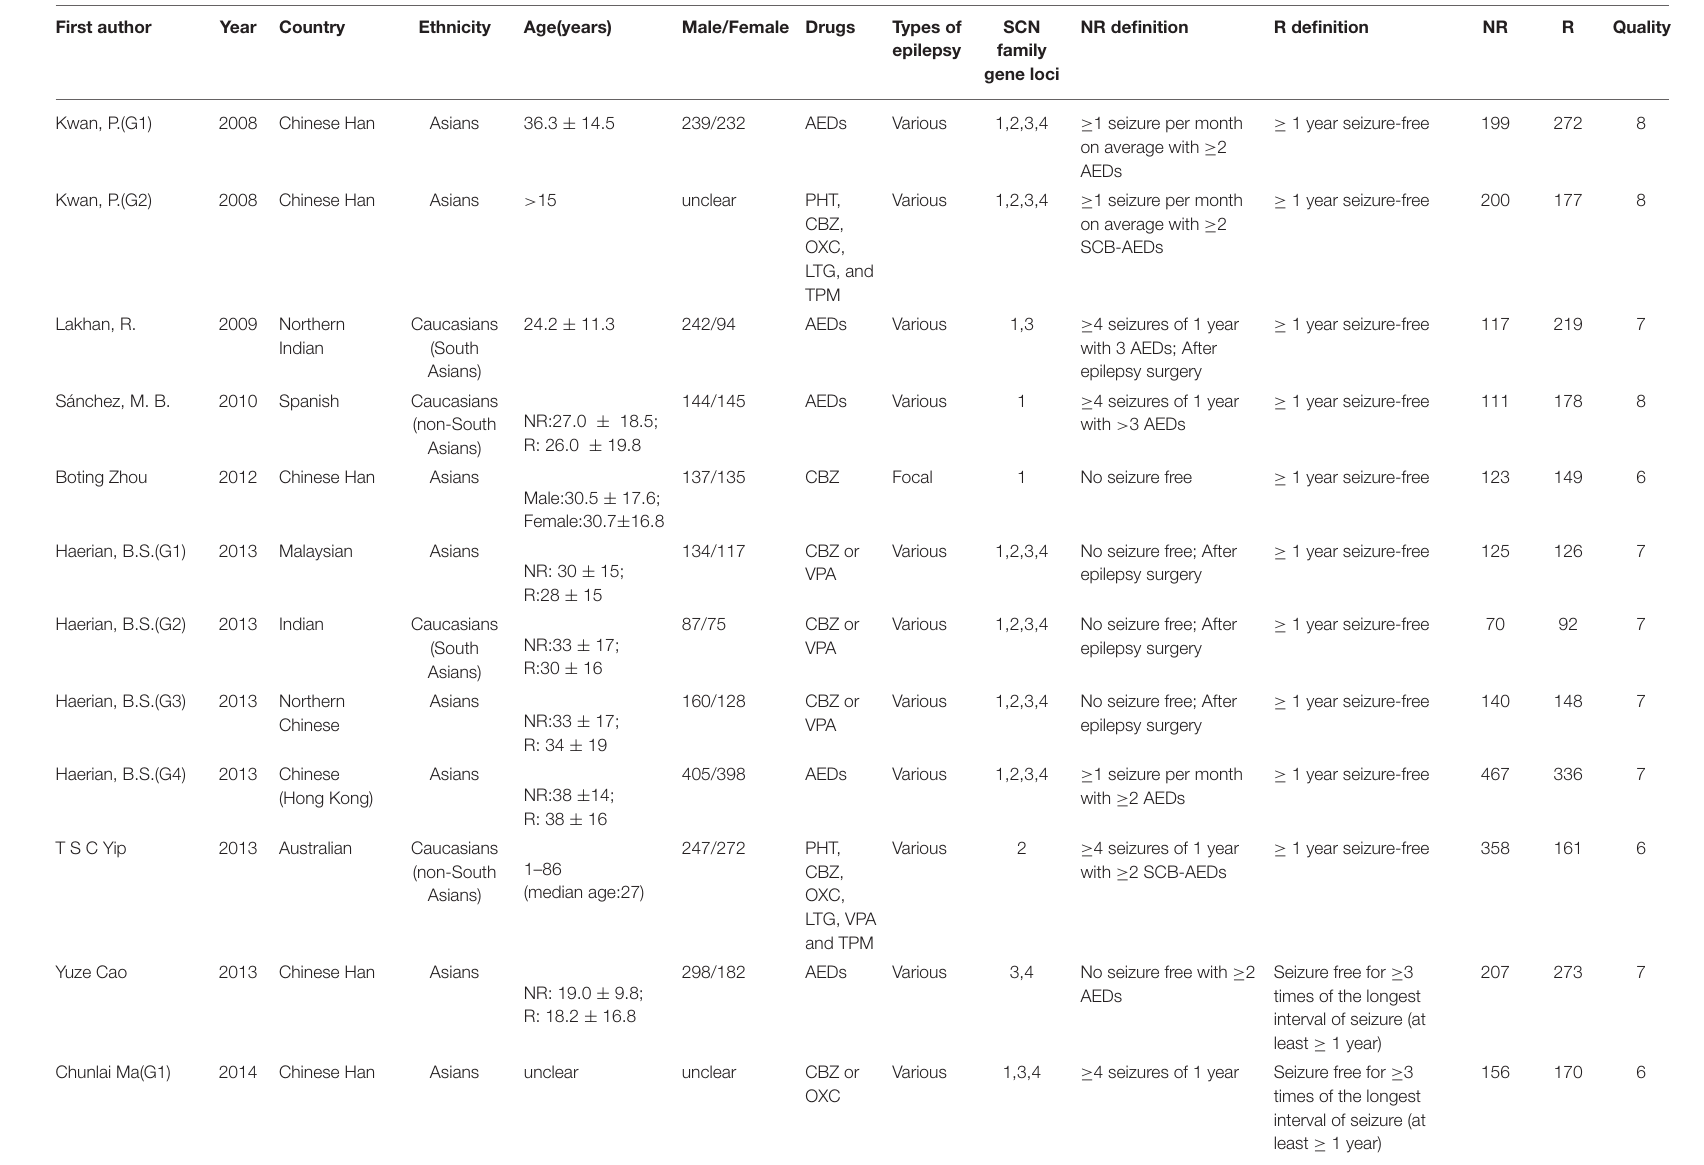
TABLE 1 | Characteristics of studies on SCN1A and SCN2A polymorphisms and resistance to AEDs included in the